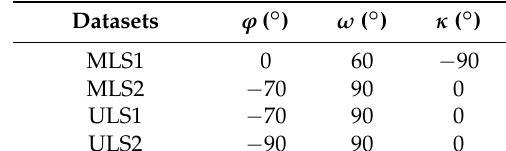
Table 1. The designed boresight angles between laser scanners and Global Navigation Satellite System (GNSS)/Inertial Measurement Unit (IMU). MLS: Mobile LiDAR Scanning; ULS: UAV light detection and ranging (LiDAR) Scanning.